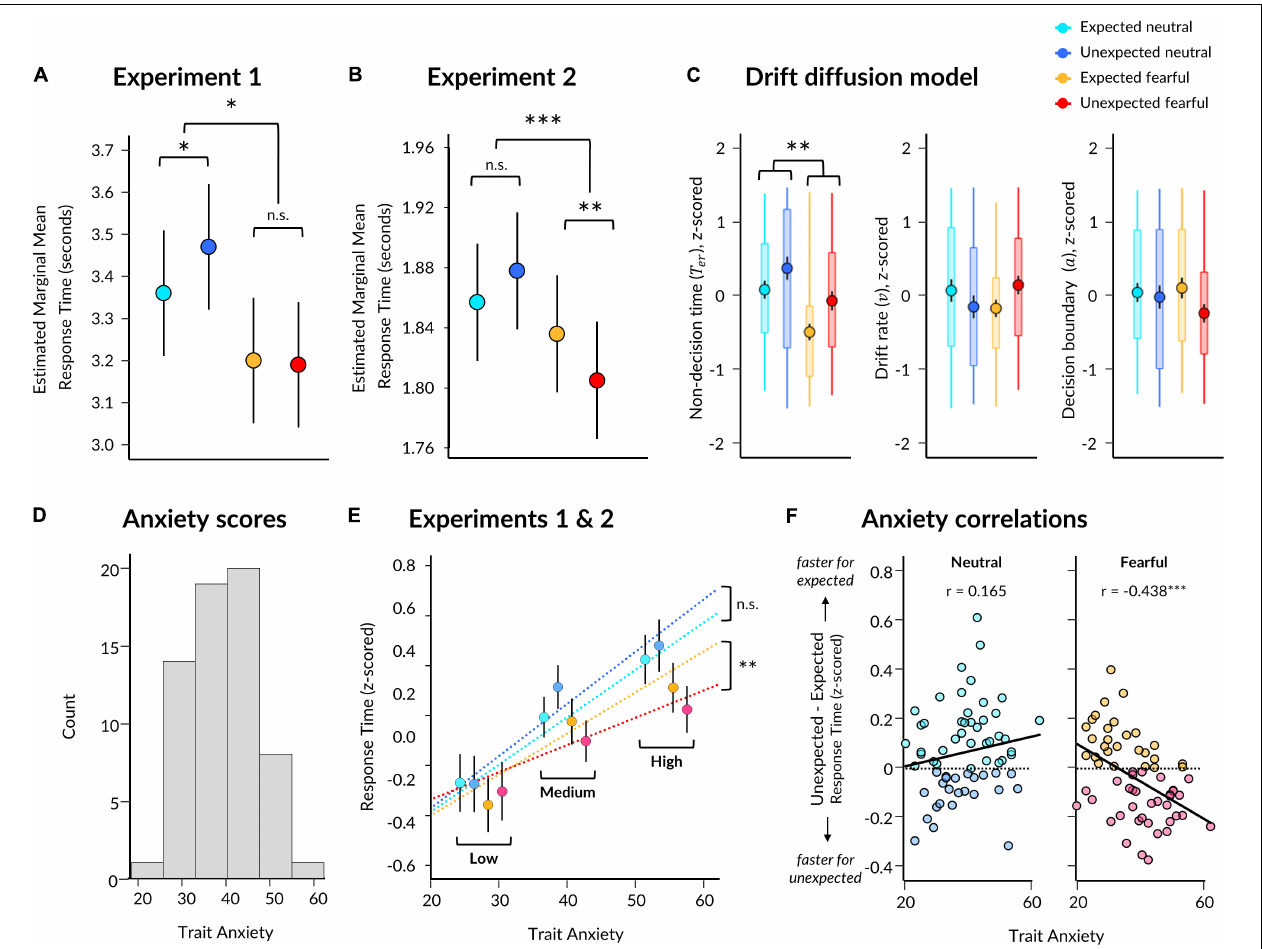
FIGURE 2 | Behavioural results from Experiments 1 and 2. (A) Estimated marginal means for each condition from a linear mixed effects model for Experiment 1. Significant two-way interaction and simple effects are indicated by asterisks. Error bars represent standard error. (B) Same as (A) except for Experiment 2. (C) Parameter estimates per condition derived from the EZ Drift Diffusion model. Markers represent mean across all subjects, with black vertical lines indicating standard error of the mean. Boxes represent 25th and 75th percentiles and coloured vertical lines indicate range across subjects. Significant main effect of emotion is indicated for non-decision time. (D) Trait anxiety scores for participants from both Experiments 1 and 2. (E) Estimated slopes from the linear mixed effects model of response time, which included a three-way interaction between expectation, emotion, and trait anxiety (x axis). Participant mean z-scored response times are shown (markers with error bars indicating standard error of the mean) with participants grouped into low ( z < − 0.5), medium ( z = − 0.5 and = 0.5), and high ( z > 0.5) trait anxiety for visualisation purposes only. (F) Correlations between trait anxiety (x axis) and the effect of expectation (unexpected minus expected; y axis) on z-scored response times to neutral (left) and fearful (right) faces, using pooled data from Experiments 1 and 2. Higher scores on the y axis indicate faster responses to expected faces (lighter points), while lower scores indicate faster responses to unexpected faces (darker points) for the respective facial expression. Pearson correlation coefficients are displayed. * p < 0.05, ** p < 0.01, *** p <